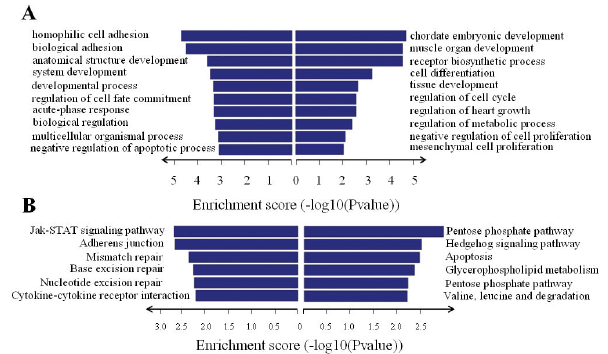
Figure 3. GO and pathway analysis. The first 10 Go ID ( A ) and first six pathways ( B ) that exhibited significant differences between VSD and NC groups are listed (left and Right panel show the associated coding genes of downregulated and upregulated lncRNAs, respectively).